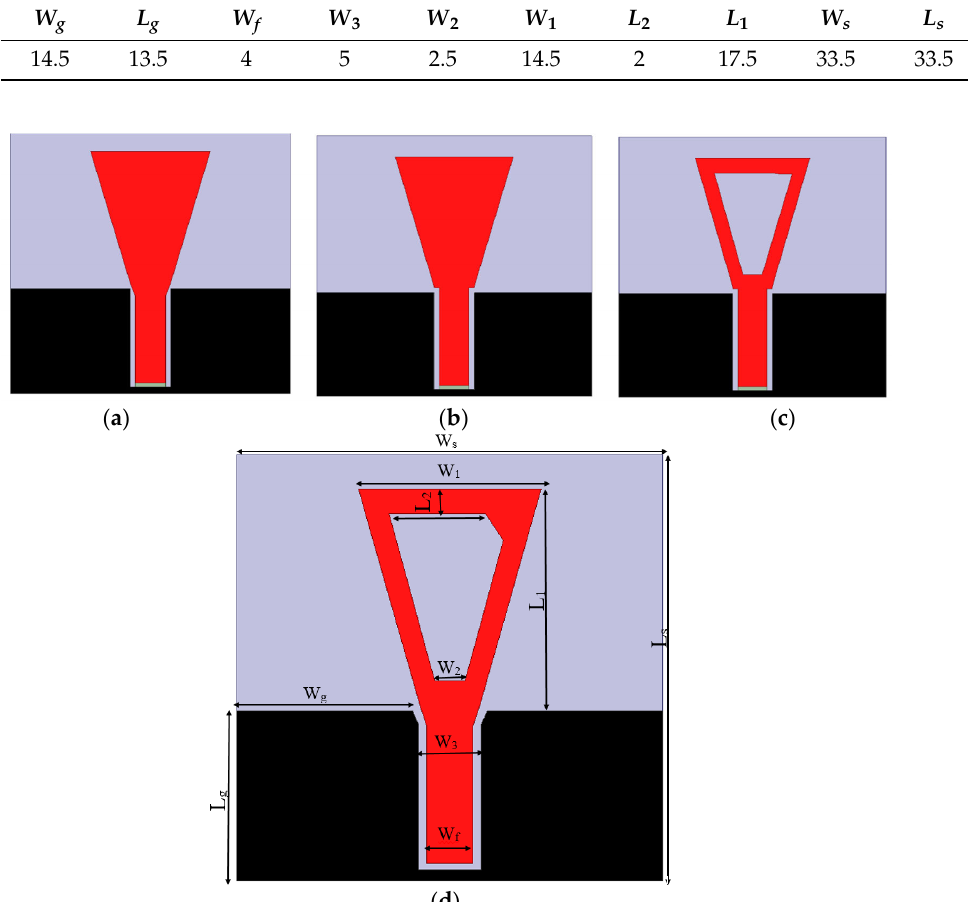
Table 1. The optimized dimensions of the proposed antenna (all dimensions in mm).